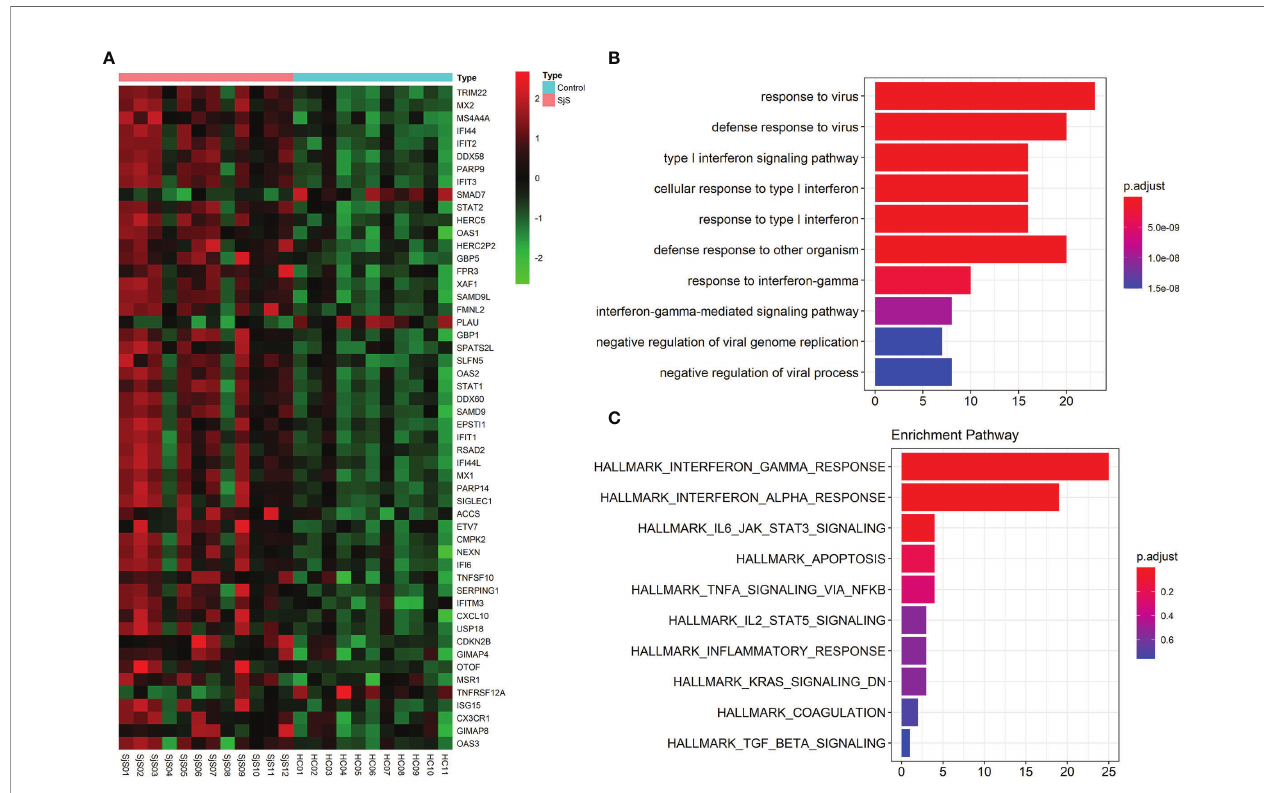
FIGURE 3 | Bulk transcriptome analyses of monocytes identify key genes and functional pathways involved in SjS. (A) , Top DEGs in the bulk transcriptome analyses of monocytes from SjS patients. (B) , Main enriched GO pathways of those signi fi cant DEGs via clusterPro fi ler. (C) , Main enriched Hallmark pathways of those signi fi cant DEGs via clusterPro fi